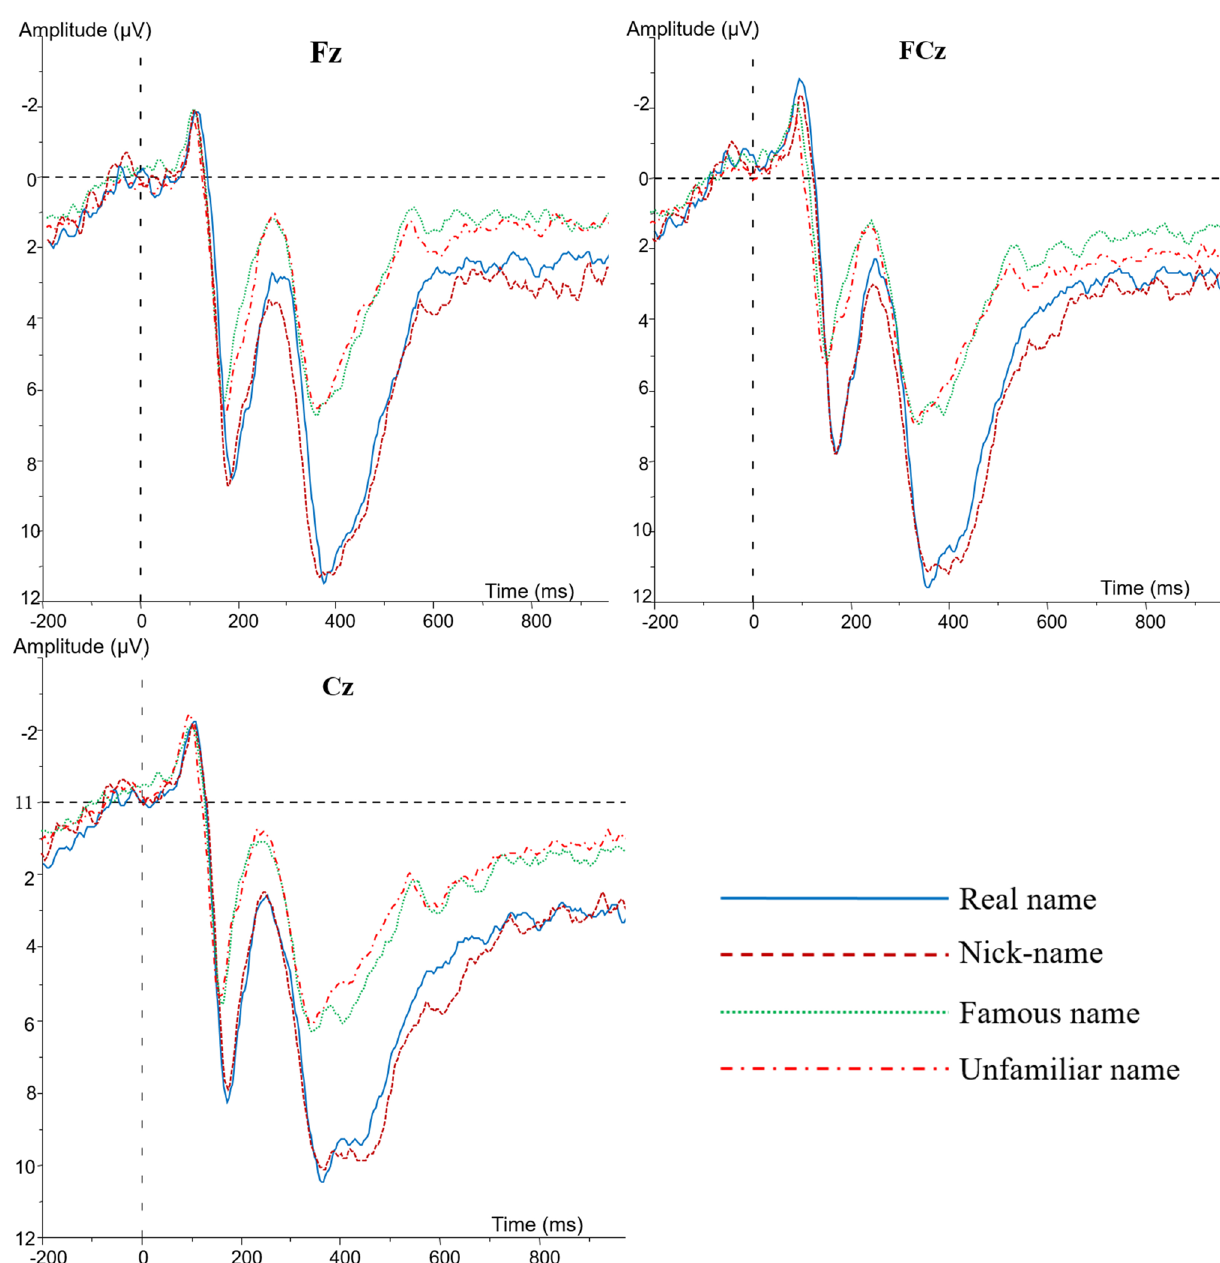
Figure 3. Averaged ERPs at FZ, FCZ, and CZ locations for different